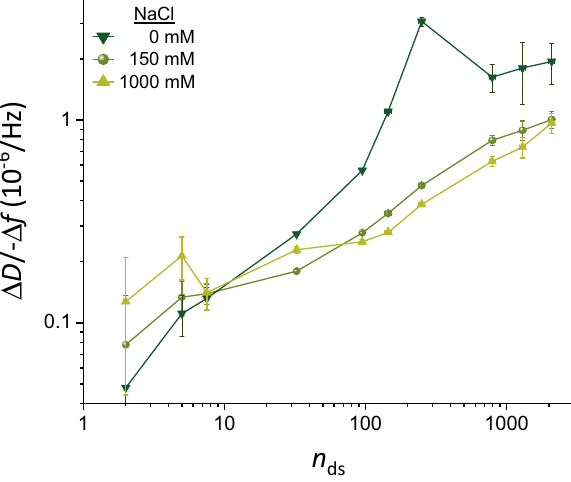
Figure 5. Effect of ionic strength on Δ D /− Δ f ratios. Double logarithmic plot of Δ D /− Δ f ( i = 3; frequency shifts are normalised by i ) as a function of the mean number of disaccharides ( n ds ) per HA chain, for NaCl concentrations of 0 mM, 150 mM and 1000 mM (as indicated with symbol and colour code). Representative data for one experiment per HA size are shown. The mean values represent the Δ D /− Δ f ratio measured at high GAG surface densities (i.e., the maximal surface densities that were attained in the experiments and stable at 0 mM NaCl; see Fig. S2 for original data). The error bars account for baseline drifts during GAG binding. In the cases of 0 and 1000 mM NaCl, solution effects on the QCM-D response (i.e., owing to the effect of salt on solution density and/or viscosity) needed to be corrected for with the aid of control data, and uncertainties associated with this correction are also included in the error bars (see Fig. 1c and Supplementary Methods for